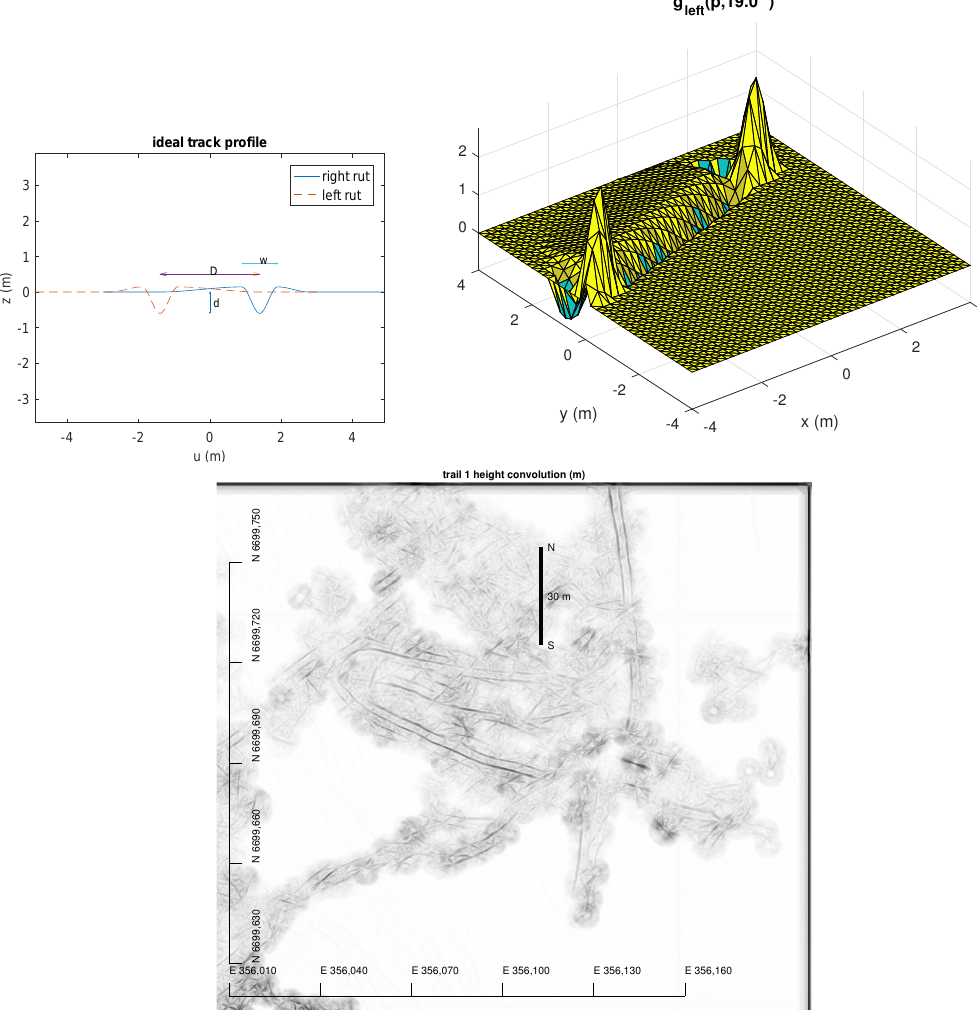
Figure 8. Left : The left and the right rut have mirror filters within a distance D , which can be set for each machine type. See Appendix B for the exact definitions. The ideal profile has an average nature, which is more pronounced at the average profile cumulated over the trail length. Right : The filter g left ( p , α ) of the left rut in an orientation α = 19 ◦ . The shape is formed by cubic splines and has a theoretically correct shape, e.g., to detect constant, gradient and unit impulses. Bottom : The result of the height convolution of Trail 1 in ETRS-TM35FIN co-ordinates. The image is a combination of the strongest responses of each orientation α